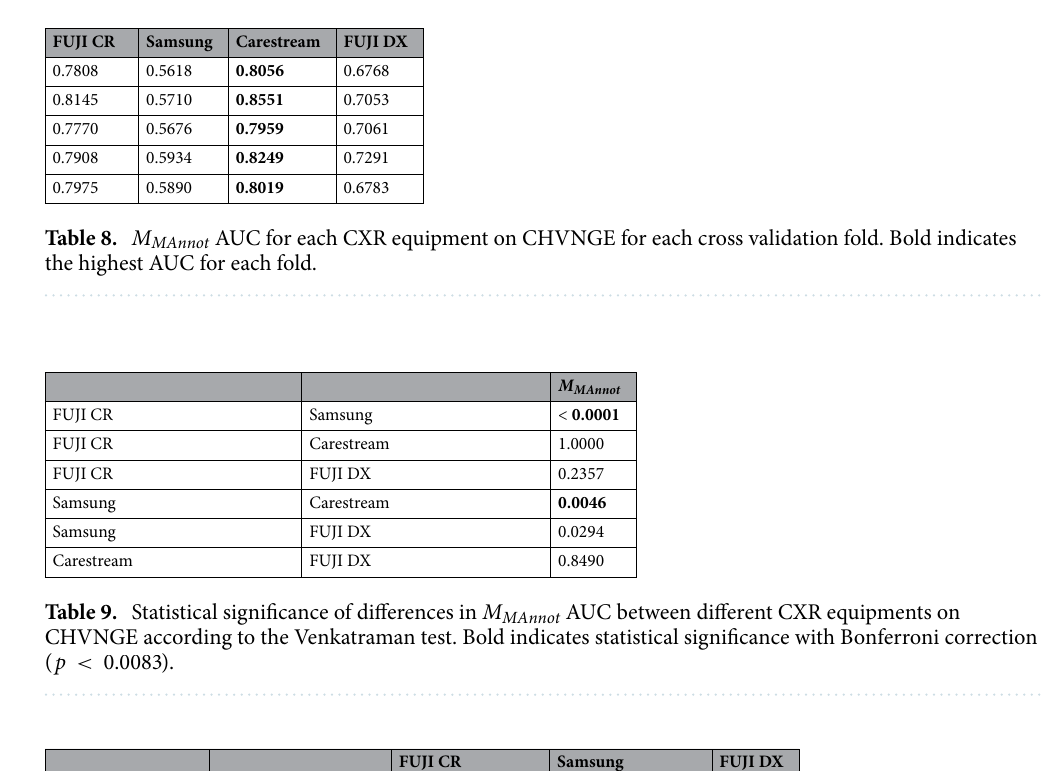
Figure 6. Equipment-wise evaluation of M MAnnot on the CHVNGE dataset. Top left: model performance on all CXRs. Top right: model and radiologist performance on CXRs annotated by radiologists (Carestream not shown due to limited data). Average model performance for all folds is shown as a line and shaded region corresponds to the 95% confidence interval. Radiologists’ performance is shown considering as positives only CXRs marked as Indicative of COVID-19 ( • ) or Indicative of COVID-19 and Undetermined ( (cid:31) ).